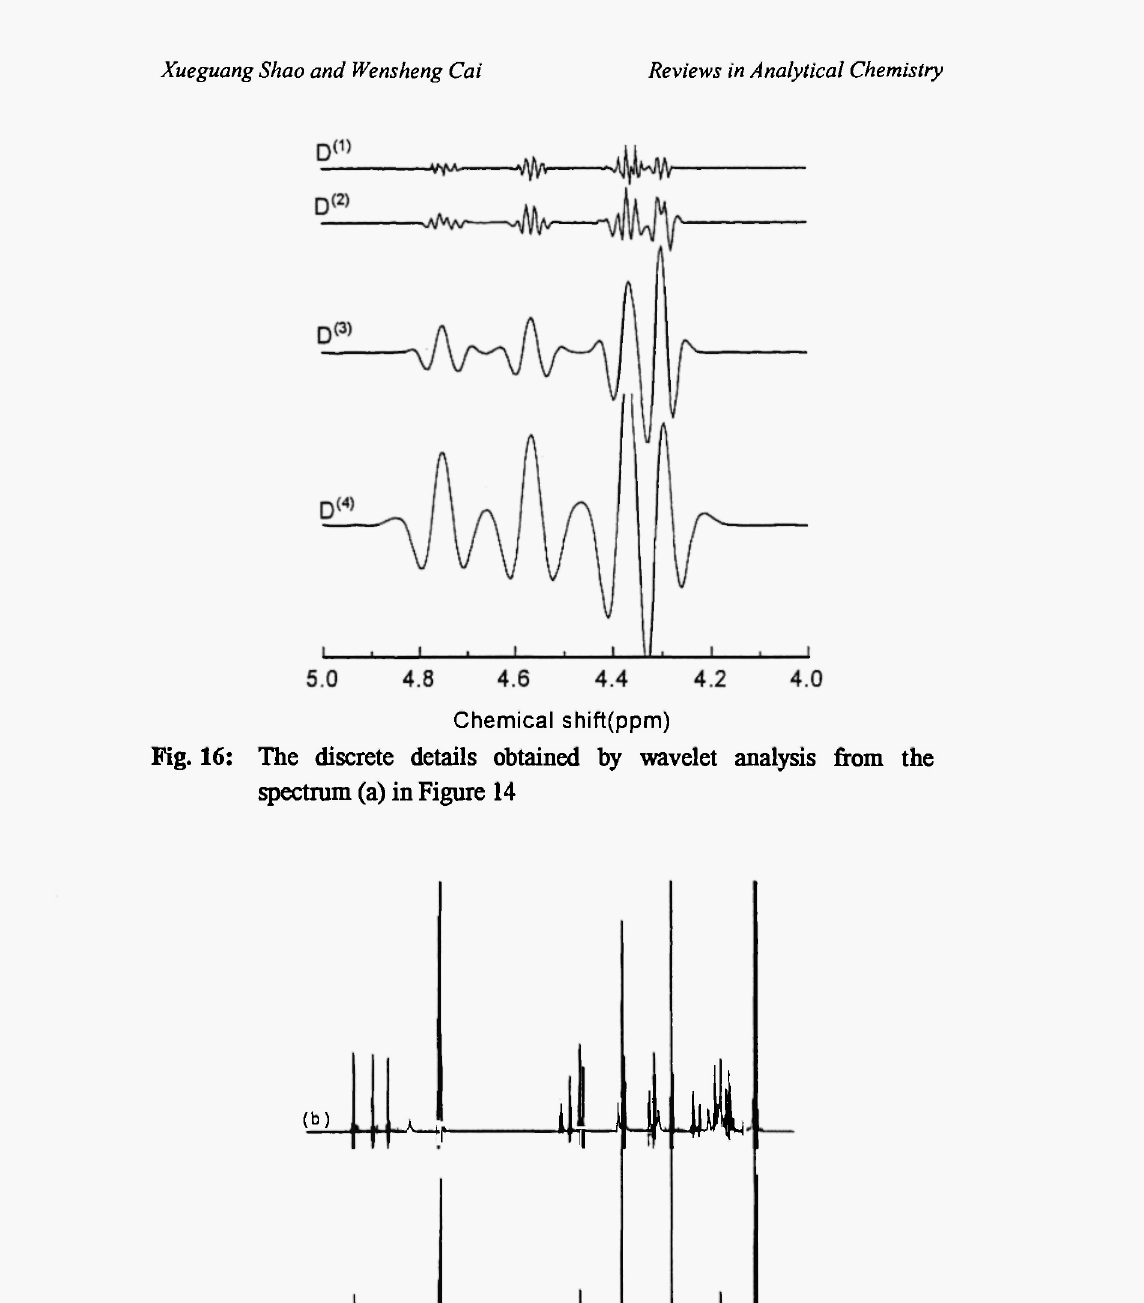
Fig. 17: The resolved spectra by wavelet